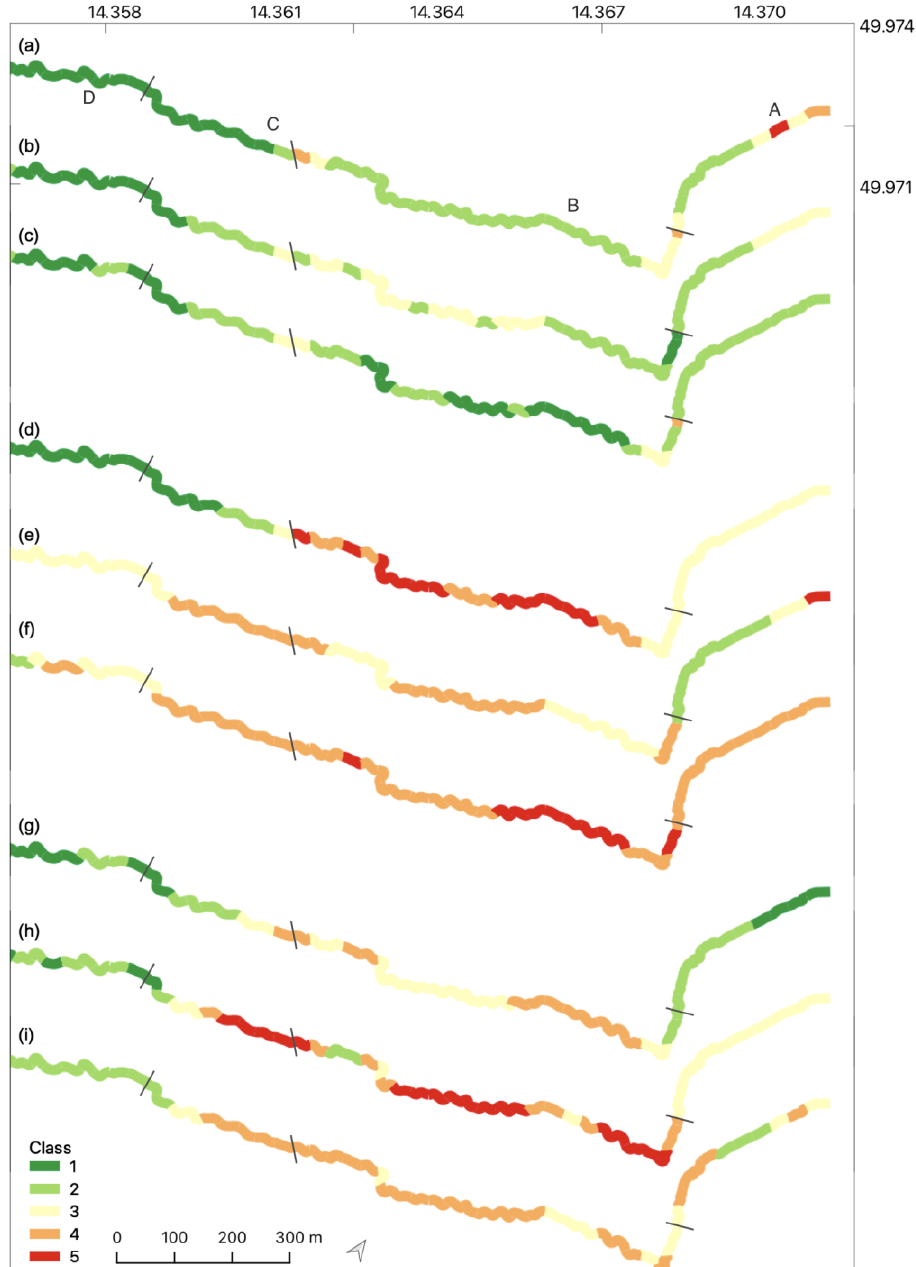
Figure A3. Assessment of restoration indicators in Lipanský brook (LIP). ( a ) Channel modifications, ( b ) Channel stability, ( c ) Bed variability, ( d ) Flow continuity, ( e ) Floodplain connectivity, ( f ) Water quality, ( g ) Vegetation coherence, ( h ) Riparian shading, and ( i ) Woody debris.